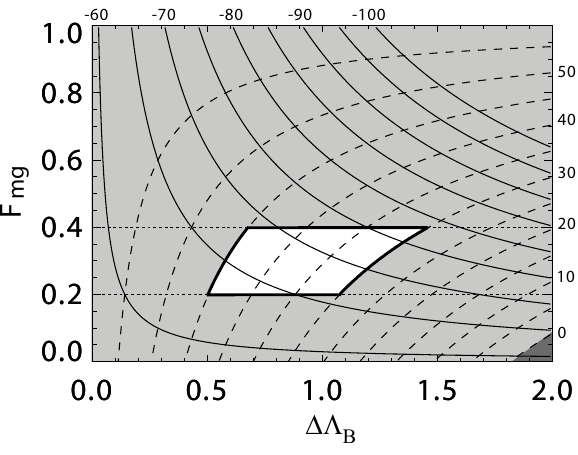
Fig. 11. Reconnection rate contours determined from Eq. (7) plot- ted on the f mg − 13 B plane, where f mg is shown on the vertical axis, and the displacement of the magnetic latitude of the dusk flow reversal boundary 13 B during the substorm is shown on the hor- izontal axis. The solid lines show contours of the nightside recon- nection rate obtained from Eq. (7a), while the dashed lines show contours of the dayside reconnection rate obtained from Eq. (7b). The dark-shaded area in the bottom right corner represents an area of inconsistent results in which the dayside reconnection rate be- comes negative. The horizontal dotted lines mark the likely range of f mg values for the substorm, with the exterior region being shaded. Also shaded is the region of unlikely dayside reconnection rates ly- ing outside the range 30–45kV. The unshaded area corresponds to the region of solutions that conforms to both these